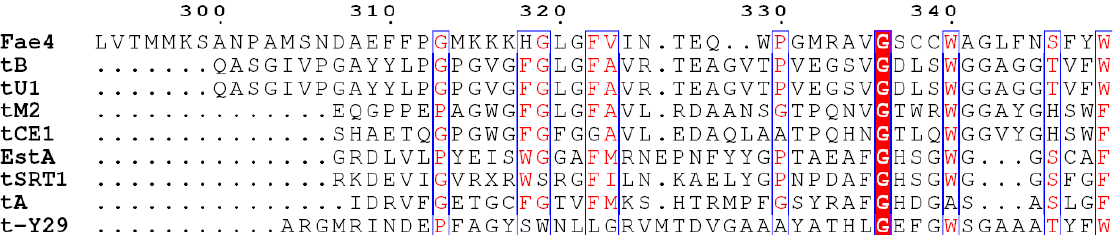
Figure 3. Multiple sequence alignment of DLFae4 and other closely related VIII family esterases.